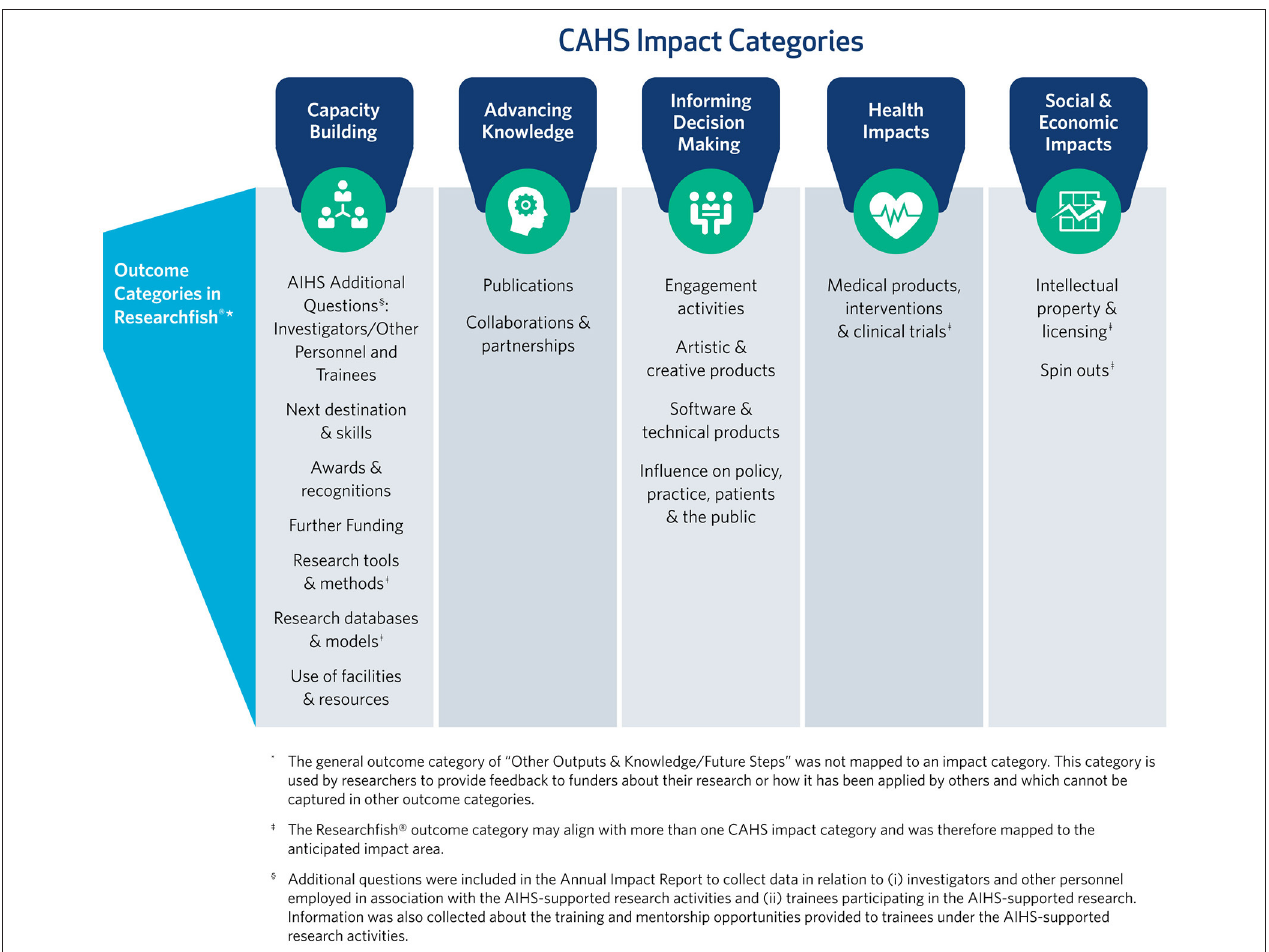
FIGURE 2 | Mapping the outcomes categories in Researchfish ® to impact